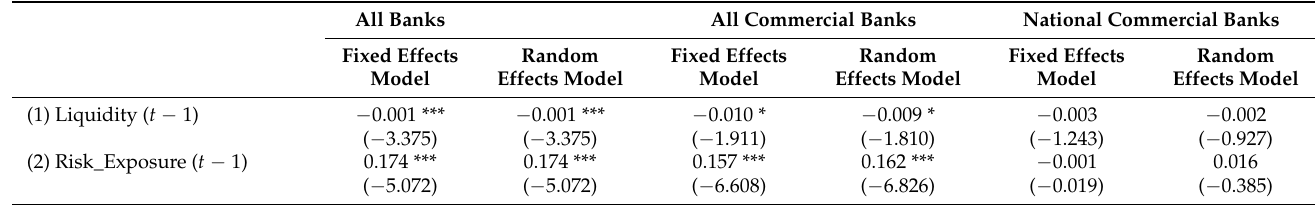
Table 9. Regression results of four variables in t − 1